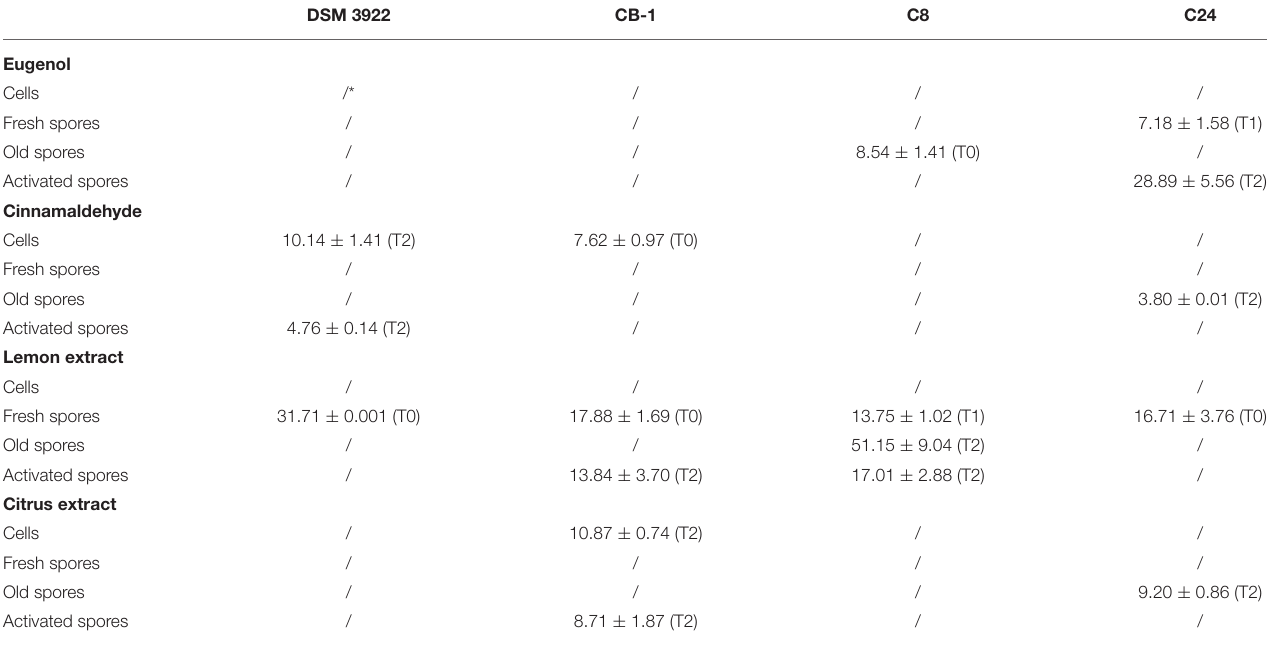
TABLE 1 | Sublethal injury (%) on A. acidoterrestris caused by eugenol (500 ppm), cinnamaldehyde (250 ppm), lemon extract (250 ppm), and citrus extract (250 ppm) immediately after application (T0), or after 1 (T1) or 2 days (T2) of incubation at 45 ± 1 ◦ C.